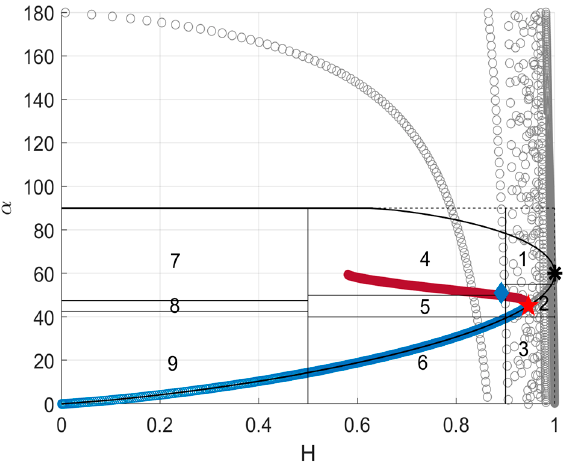
Figure 4. Two-dimensional H / α plane of volume scattering models: FRE2 volume scattering model: gray line; GVSM: red line; RPCM: blue line; FDD volume scattering model: red pentagram; YRO volume scattering model: blue diamond; An’s volume scattering model: black star.